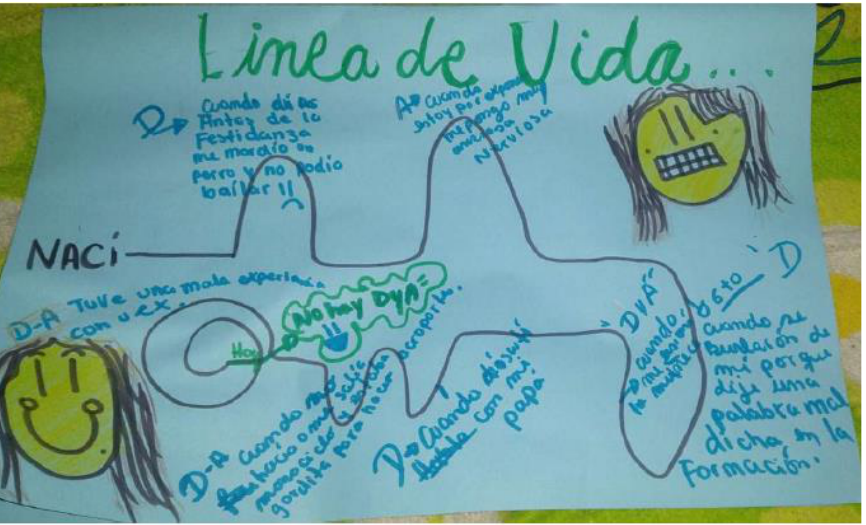
Figure 6. Lifeline of a female young adult including events that triggered depression or anxiety. Furthermore, family violence, involvement in youth gangs, disagreements or argu- ments with friends, and losing their trust in a significant figure were also identified as triggers of depression symptoms in the participants’